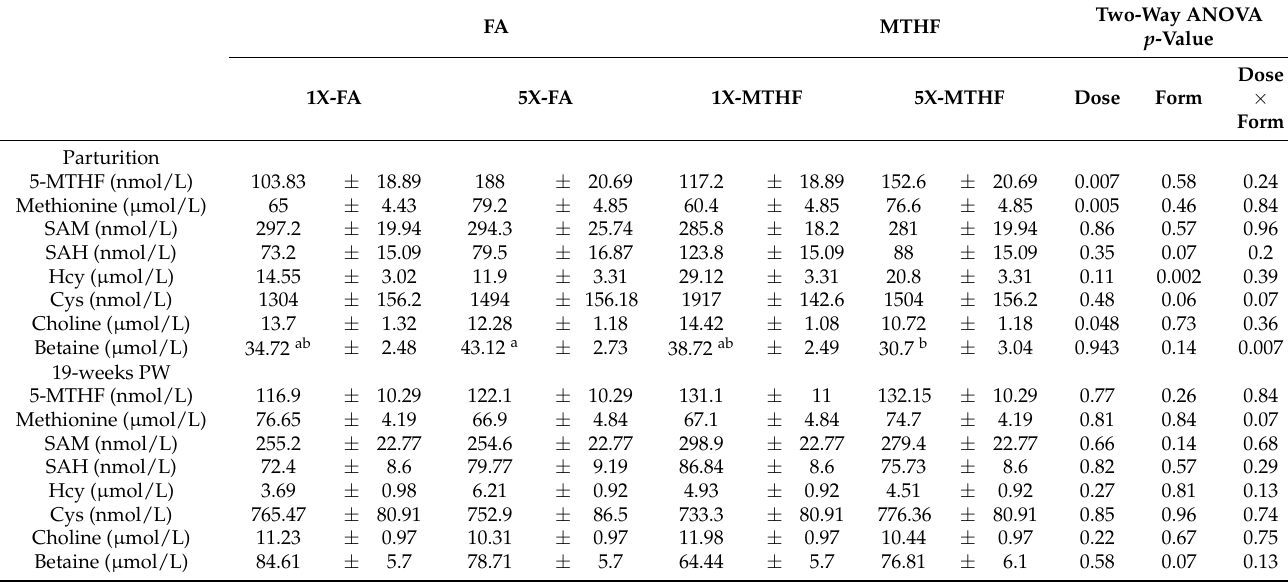
Table 1. Plasma 5-MTHF and 1-carbon metabolites upon parturition and at 19-weeks post-weaning (PW) of dams fed FA or MTHF pregnancy diets.